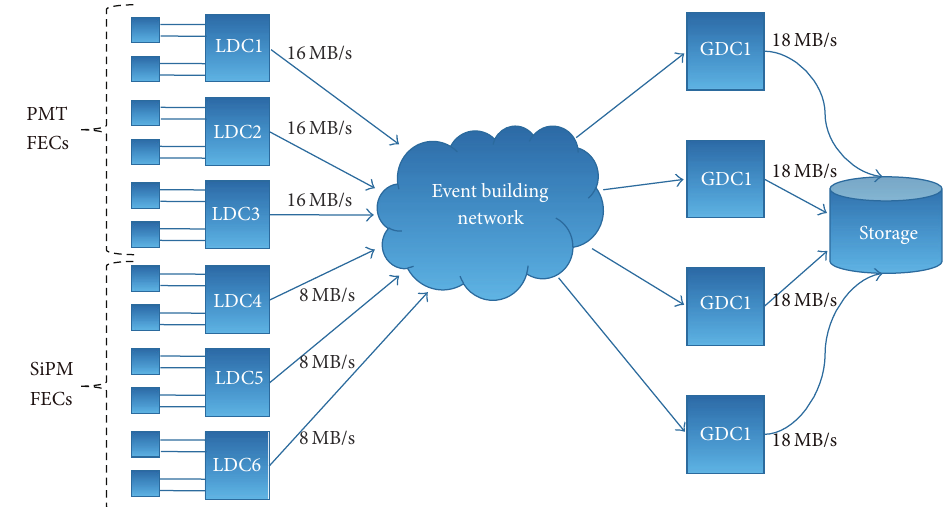
Figure 15: Scheme of the DAQ of NEXT- 100